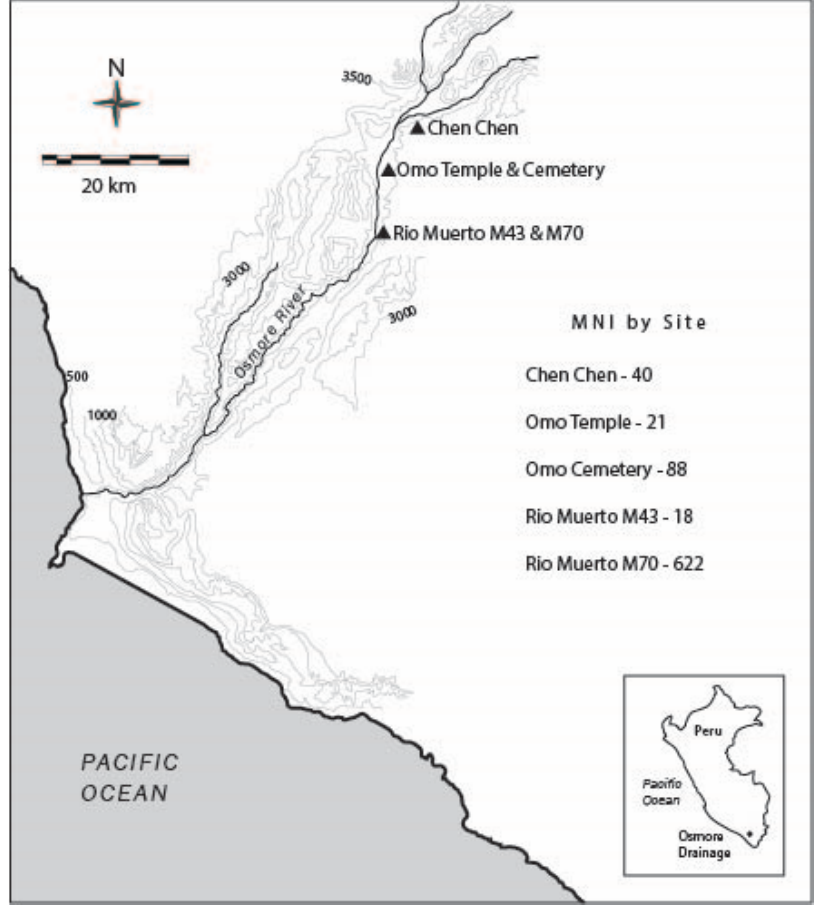
Figure 1. Map of analyzed Tiwanaku sites with anuran MNI by